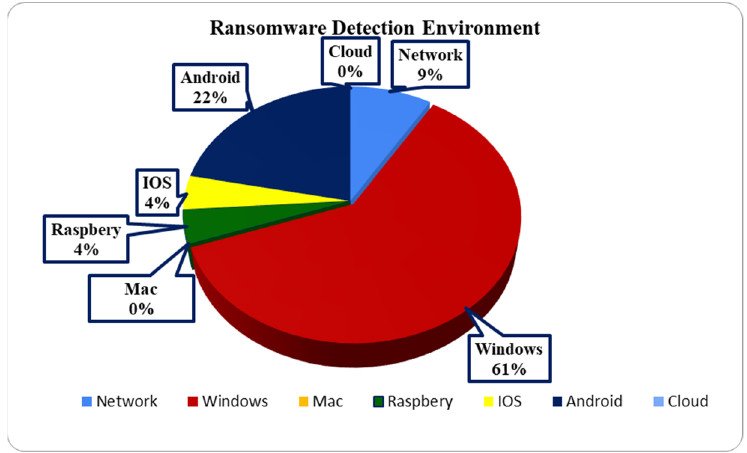
Figure 9. Different ransomware detection environments.